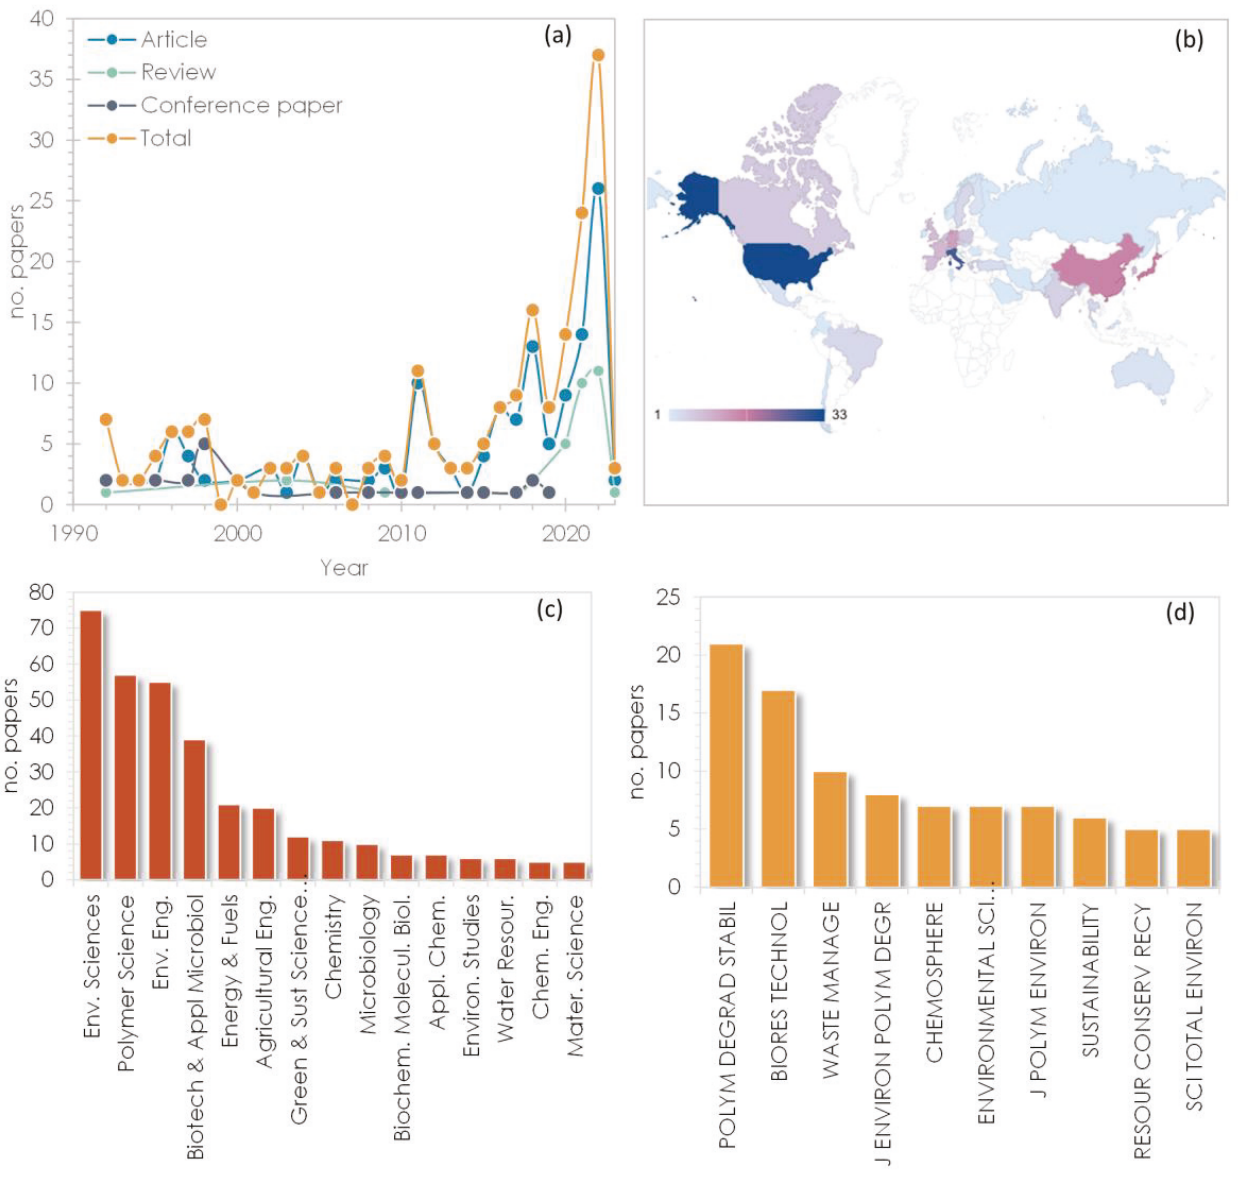
Figure 2. ( a ) Time evolution of published papers by article type; ( b ) main contributing countries (color shades correspond to the number of papers); ( c ) main WoS categories covered; ( d ) top productive journals (Note: only categories with ≥ 5 papers are included in the